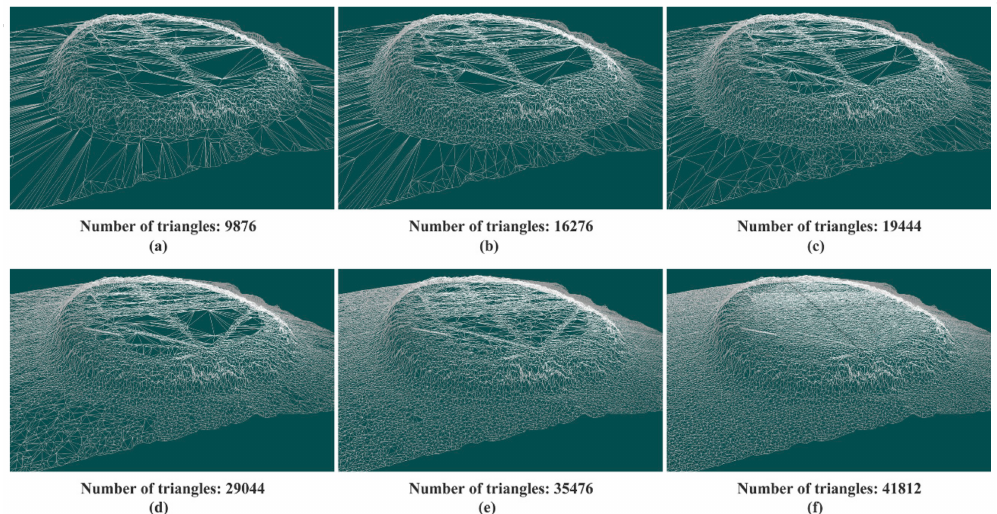
Figure 12. Di ff erent hierarchical models, corresponding to the requirements of di ff erent SVO thresholds. ( a – f ) show the representation of the terrain mesh models with the di ff erent SVO thresholds and list the number of triangles at the corresponding scale. Under the same visual distance, the number of triangles and the complexity of the geometry in the terrain model vary with the change of the SVO threshold